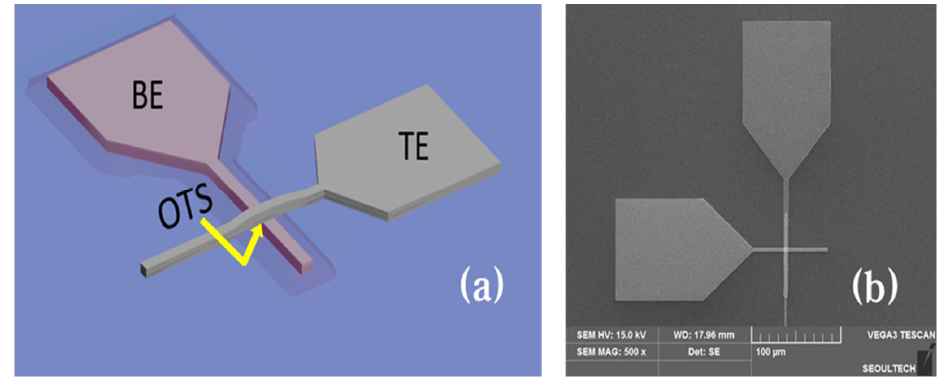
Figure 1. ( a ) Schematic diagram of the BE TiN/OTS (GT)/TE TiN structure and ( b ) SEM image of the same